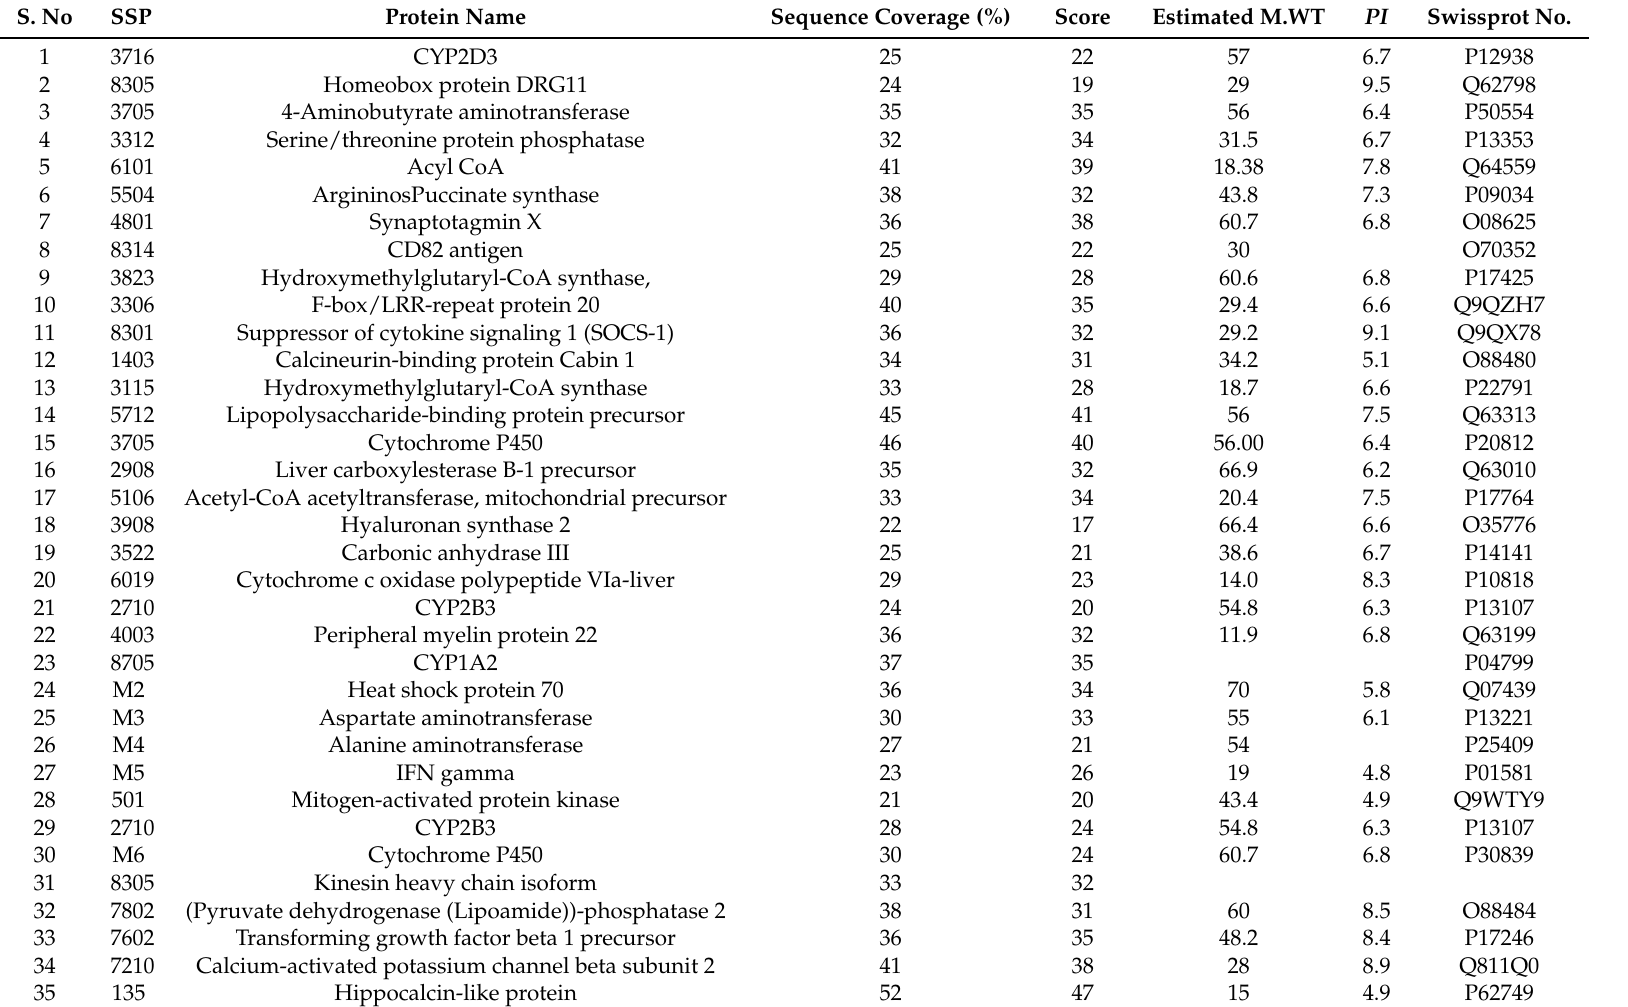
Table 3. Differentially expressed proteins in rats received 1500 mg/kg of